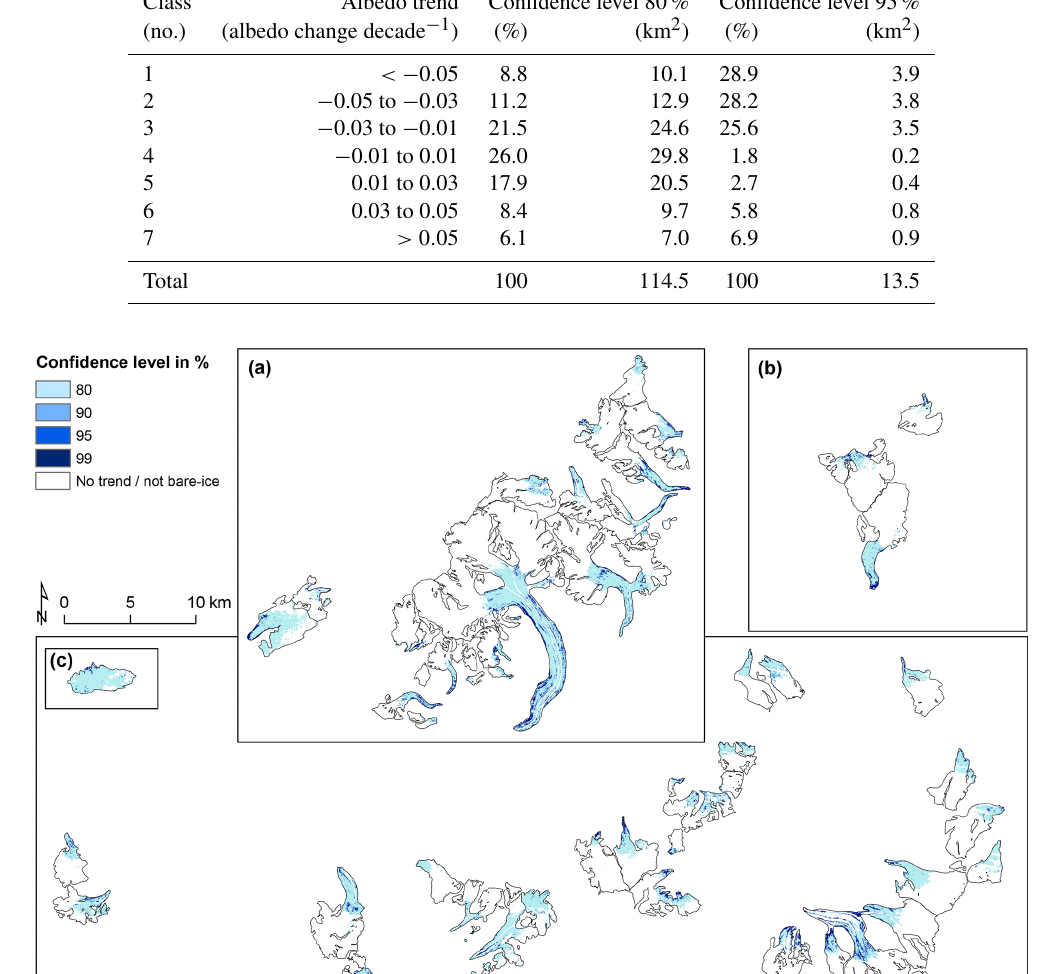
Figure 5. Confidence levels of bare-ice albedo trends over the study period 1999 to 2016 according to the MK test. See Fig. 1 for the location of the different panels in the Swiss